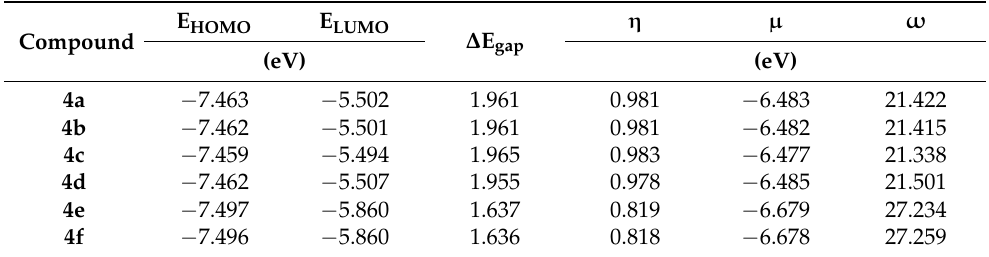
Table 6. The HOMO, LUMO energies and molecular descriptors of compounds 4a – f